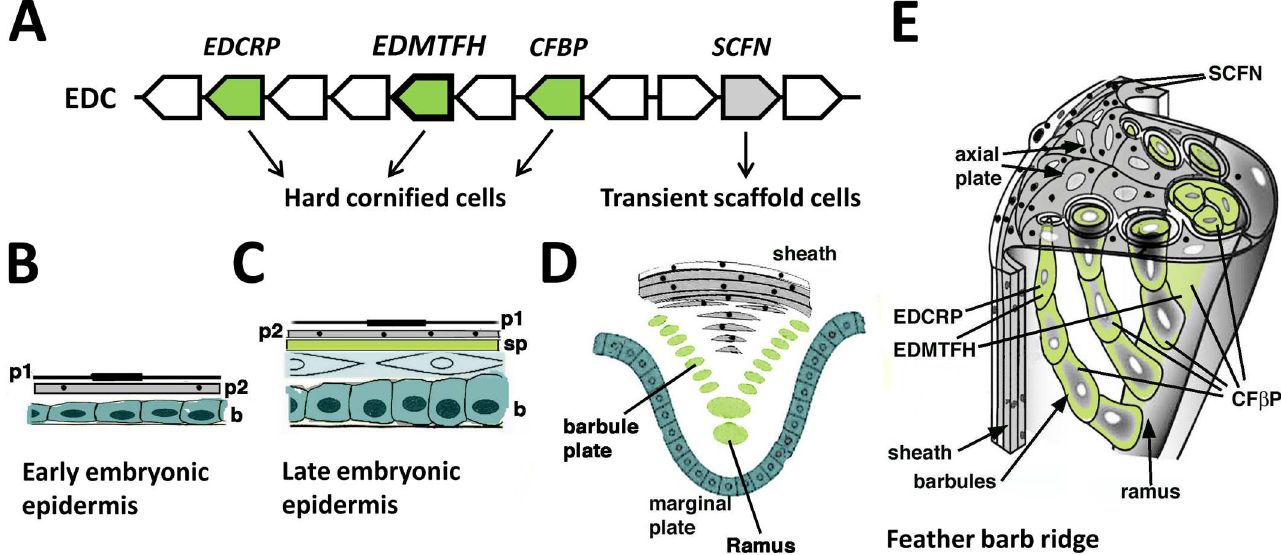
Fig 5. Schematic representation of the contribution of EDMTFH to feather cornification. ( A ) EDMTFH and other genes, that encodeproteins of the feather follicle, are locatedin the same gene cluster, the avian epidermal differentiationcomplex (EDC). EDMTFH, EDCRP and corneousfeather beta proteins (CFBPs) are components of hard cornifiedcells whereasscaffoldin(SCFN) is a componentof cells that form a transient scaffold of growingfeathers. ( B-D ) The embryonic epidermisof birds increasesthe number of layers duringdevelopment. Duringlate development, 2 layers of periderm(p1, p2) and a subperiderm (sp) are present abovethe definitiveepidermis( C ). The feather barb ridge has a topologically similar organization as late embryonic epidermis on scutate scales wherebythe equivalents of the peridermform the feather sheath and the axial plate, and barbulescells and rami are equivalent to the subperiderm ( D ), as suggestedby common expressionof protein markers. A 3-dimensional depictionof a growingbarb ridge of a down feather indicates the different roles of cornifyingcells (green) and transient scaffoldingcells (grey) in the morphogenesisof feathers ( E ). Periderm granulescontaining scaffoldinare indicatedas black